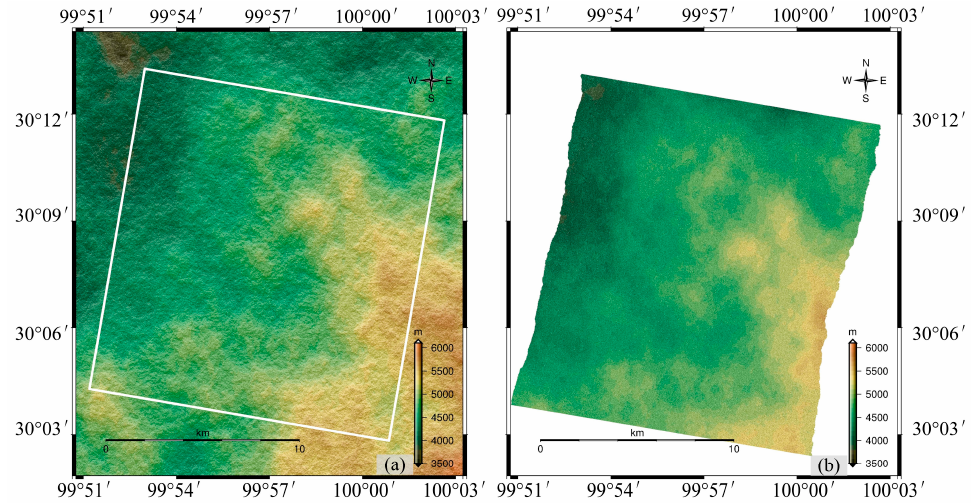
Figure 5. ( a ) is DEM simulated using fractional Brownian motion, the white rectangle corresponds to ( b ) the spatial coverage of SLC image.